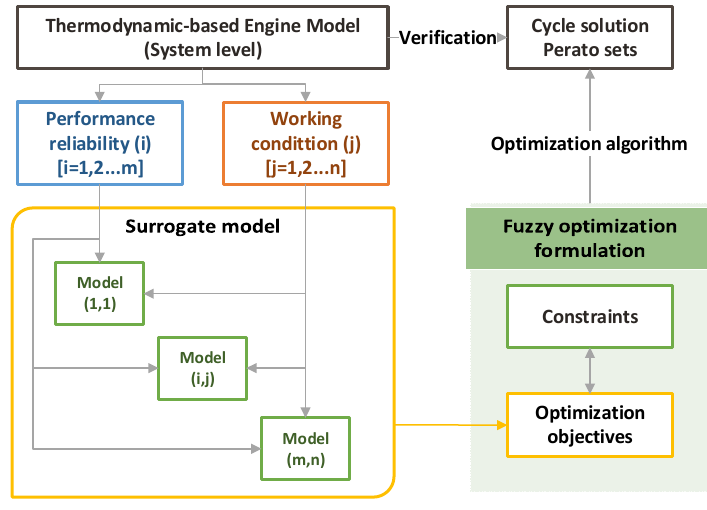
Figure 3. Reliability-based multi-design point approach.